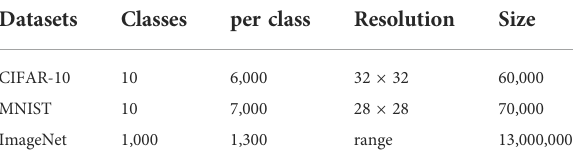
TABLE 2 Traditional image